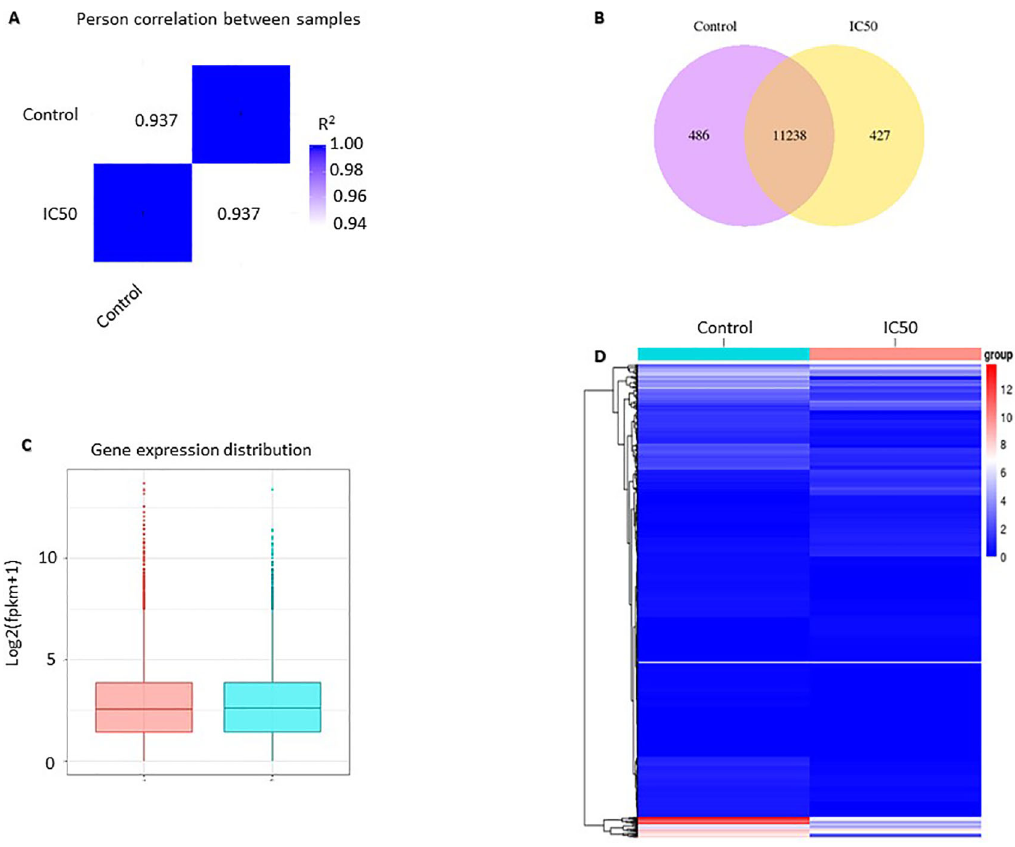
Figure 2. Gene expression profile of A549 cells after C. sappan extract treatment for 24 h. (A) Pearson correlation; (B) co-expression Venn diagrams; (C) gene expression distribution; (D) heatmap